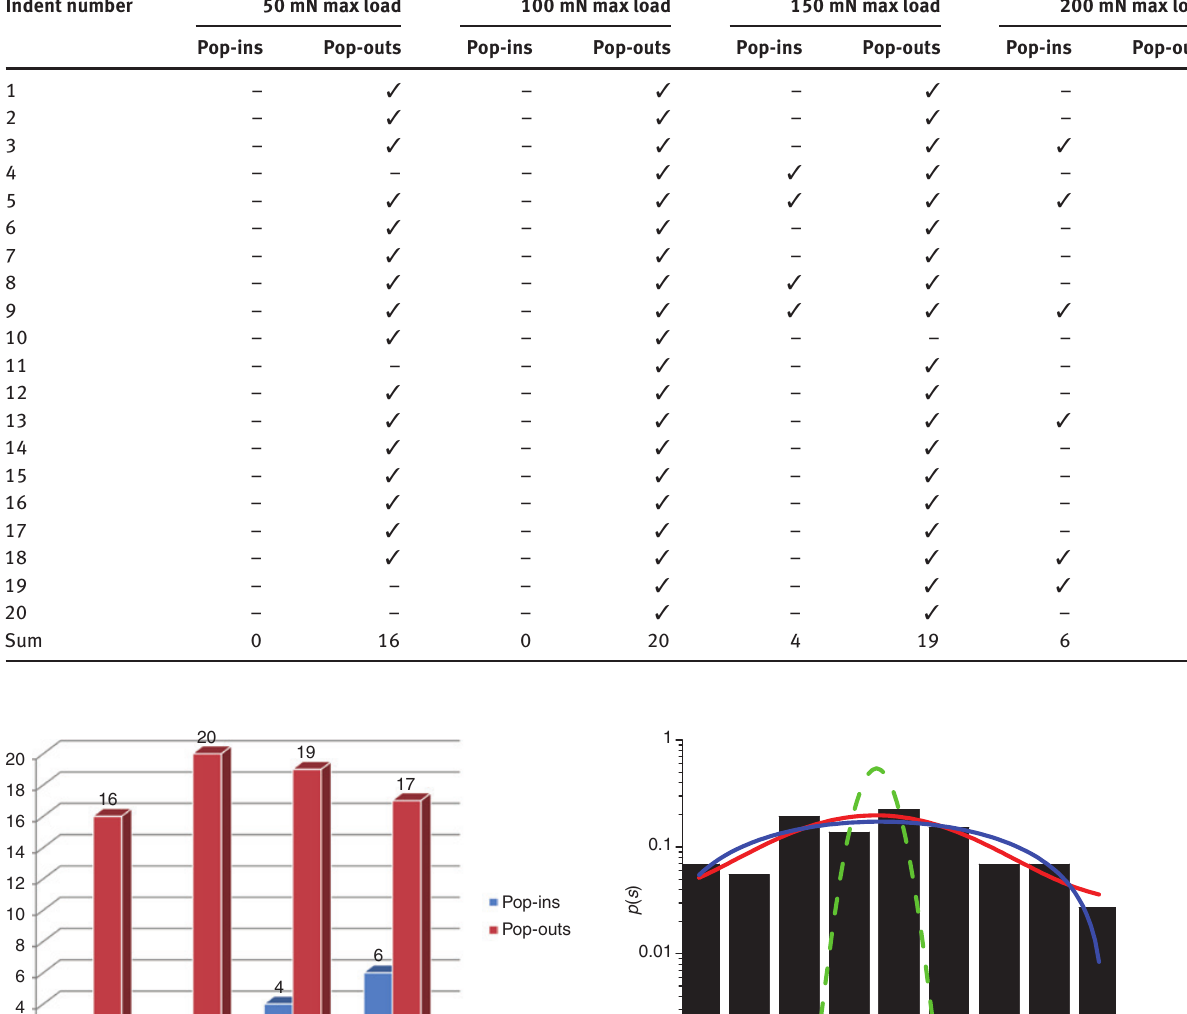
Table 2: Table summarizing the appearance of pop-ins and pop-outs, in monocrystalline silicon for different loads between 50 and 200 mN. Indent number